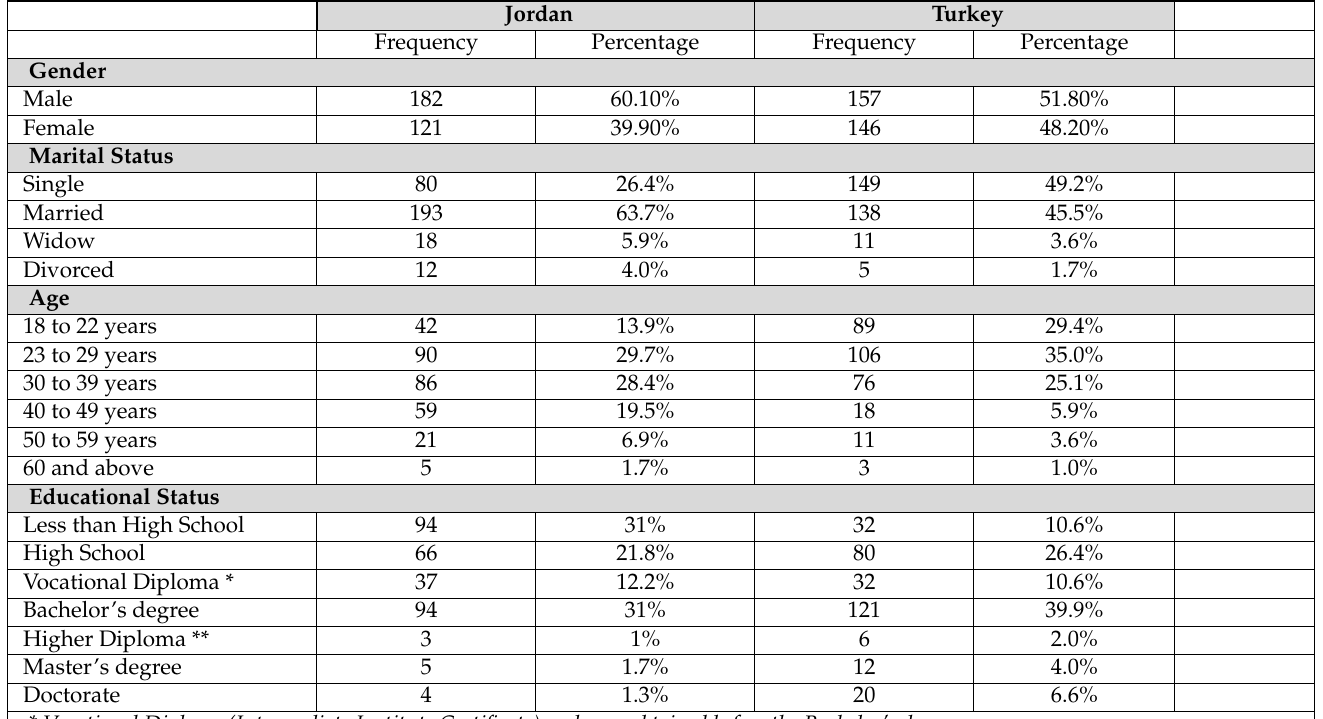
Table 2. Demographic Data and Living Characteristics of the Questionnaire